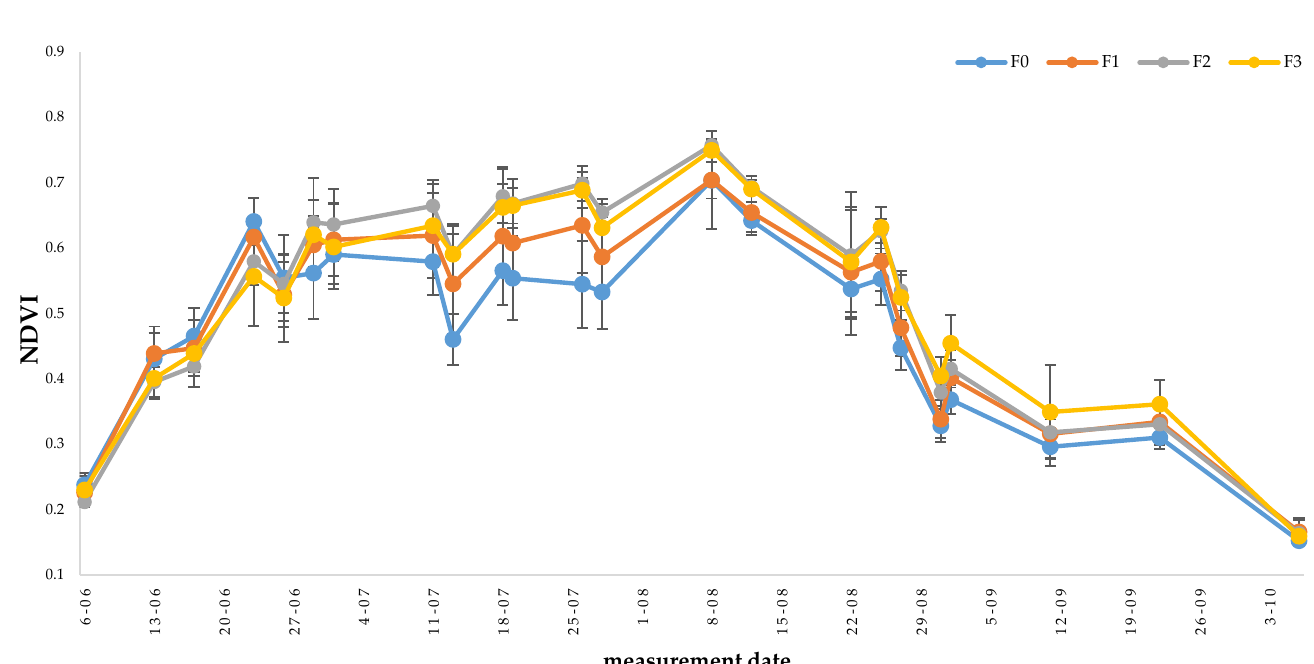
Figure 3. Normalized Difference Vegetation Index (NDVI) during the growing season of maize depending on the fertilization applied (F0 — control; F1 — foliar fertilization; F2 — localized fertilization: microgranules for precision application into the soil; F3 — localized fertilization: microgranules for precision application into the soil with foliar fertilization).